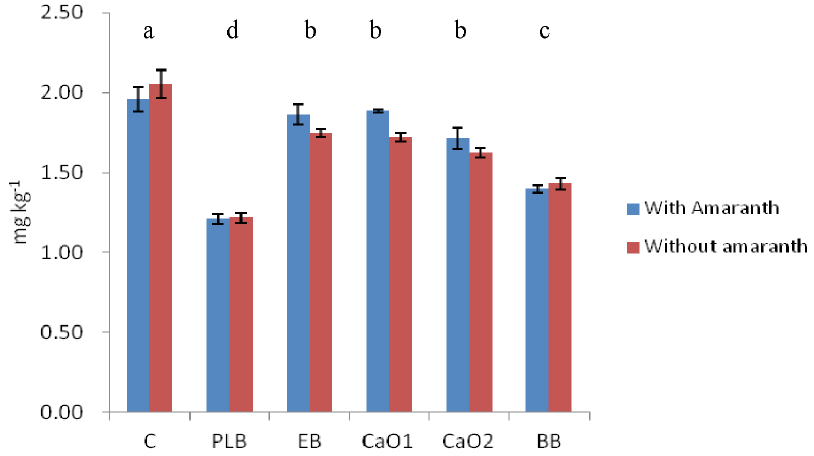
Figure 2. DTPA extracted Cd for all the treatments at the end of the experiment. Different letters in the same indicate statistical significant differences for the factor ‘‘type of amendment’’ (P , 0.05).